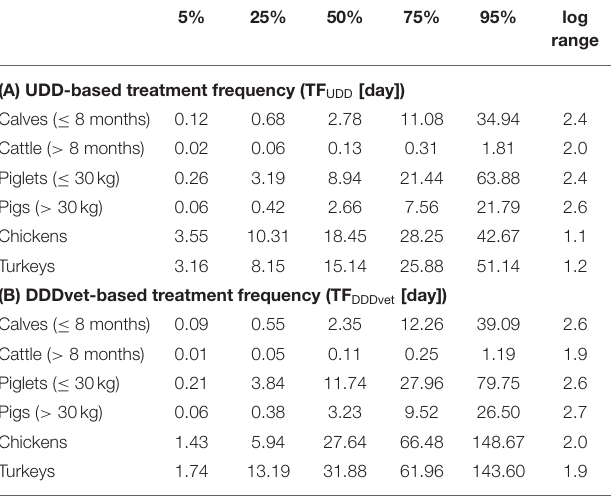
TABLE 2 | Quantiles of the distributions of (A) UDD-based treatment frequencies, TF UDD , and (B) DDDvet-based treatment frequencies, TF DDDvet , for each of the six animal populations covered by the German benchmarking